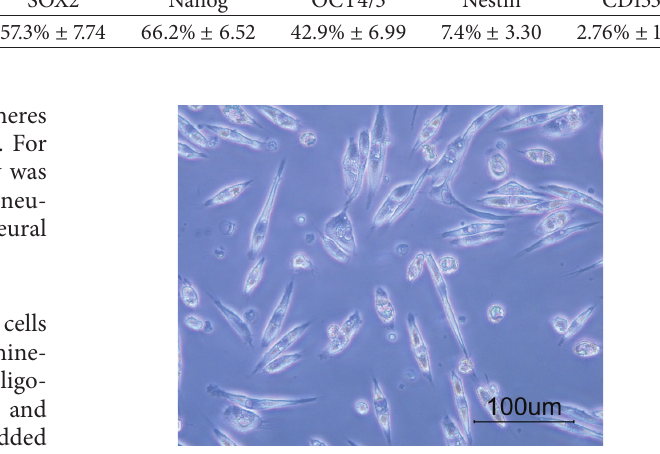
Figure 1: The breast milk-derived cells showed a fusiform morphol- ogy with few